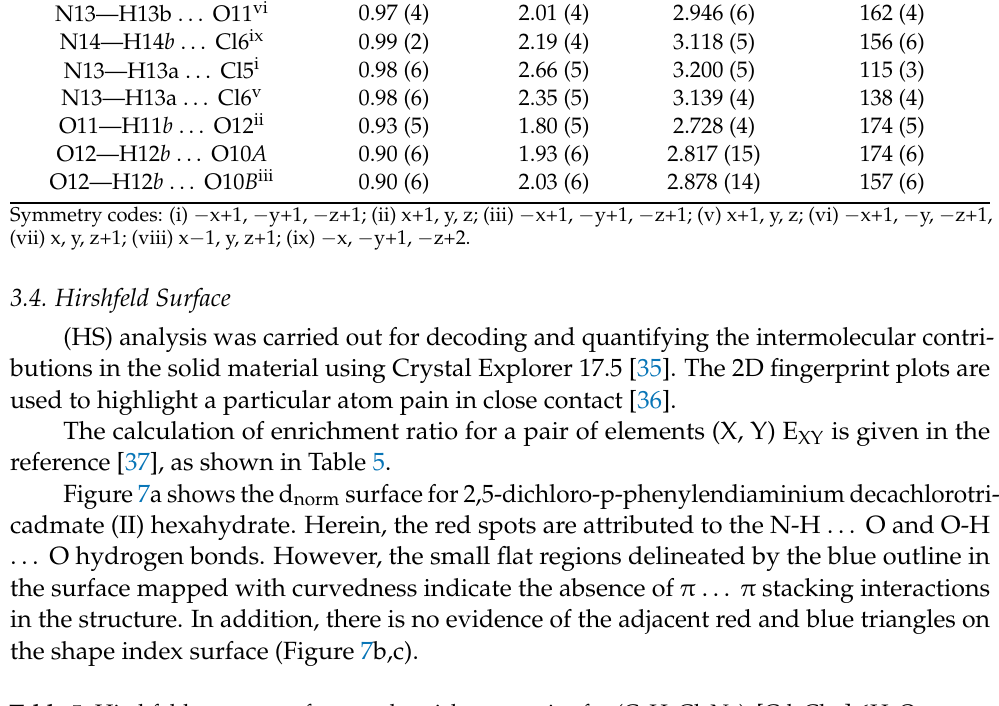
Table 5. Hirshfeld contact surfaces and enrichment ratios for (C 6 H 8 Cl 2 N 2 ) 2 [Cd 3 Cl 10 ] · 6H 2